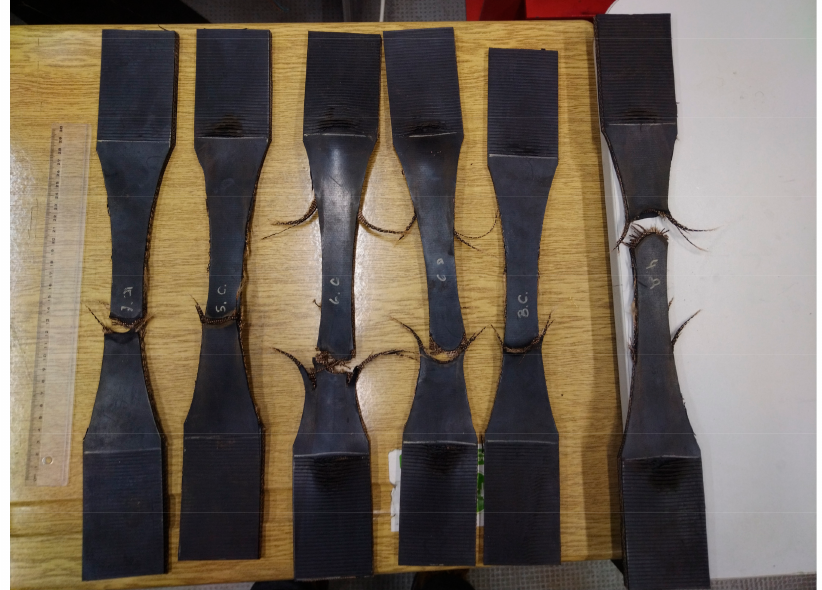
Figure 9. Some of the fractured specimens after fatigue